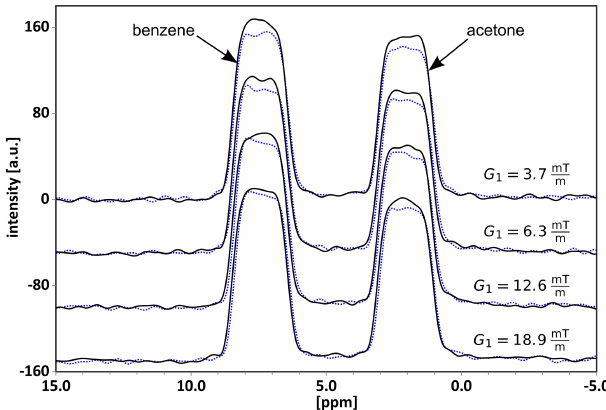
Figure 4. Results from the four SNGE experiments on a 1 : 1 mix- ture of acetone and benzene (with 10% of acetone-d6 for locking) recorded, according to the three-gradient sequence of Fig. 3, using the indicated G 1 gradient amplitudes at a constant G 3 of 1 . 6 mT , m while adjusting G 2 according to Eq. (2). The respective lower traces correspond to the I ( + ) sub-experiment, while the higher ones are of the I ( − ) measurements. SNGE spectra are presented for four G 1 gradient values, increasing from top to bottom as follows: 3 . 7, 6 . 3, 12 . 6, 18 . 9 mT ( δ 1 = 2, (cid:49) = 0 . 015, δ 2 = 1ms, a gradient stabi- m lization delay (cid:15) = 0 . 05ms, and an acquisition time t aq = 3 . 69ms). Chemical shifts include 2 . 1ppm (acetone) and 7 . 2ppm